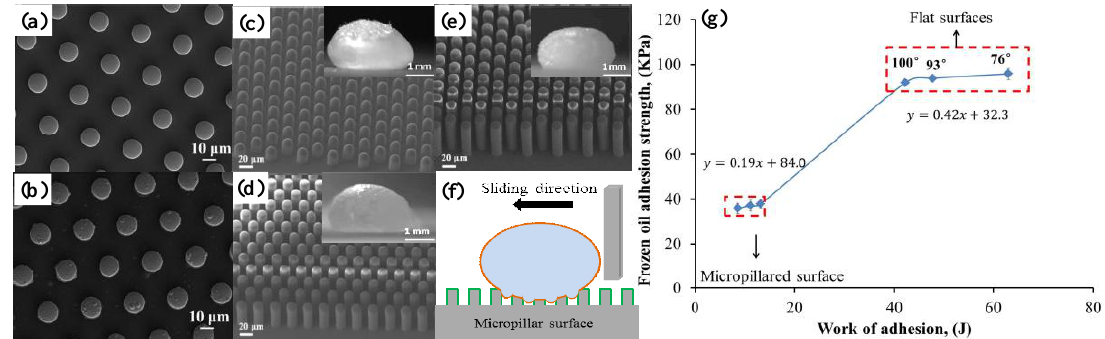
Figure 14. ( a , b ) The overall structure of trichloro(1H,1H,2H,2H-perfluorooctyl)silane (FDTS) blended and coated PDMS micropillars, respectively [216]; reproduced with permission from Elsevier. ( c – e ) The micropillars with aspect ratios of 1.5, 3.0 and 4.5 and the corresponding frozen oil droplets [217]. ( f ) The carton illustration of frozen oil knock-off test [217]. ( g ) The systematic relationship between frozen oil adhesion, surface structure, and surface composition [217]; reproduced with permission from the American Chemical Society.